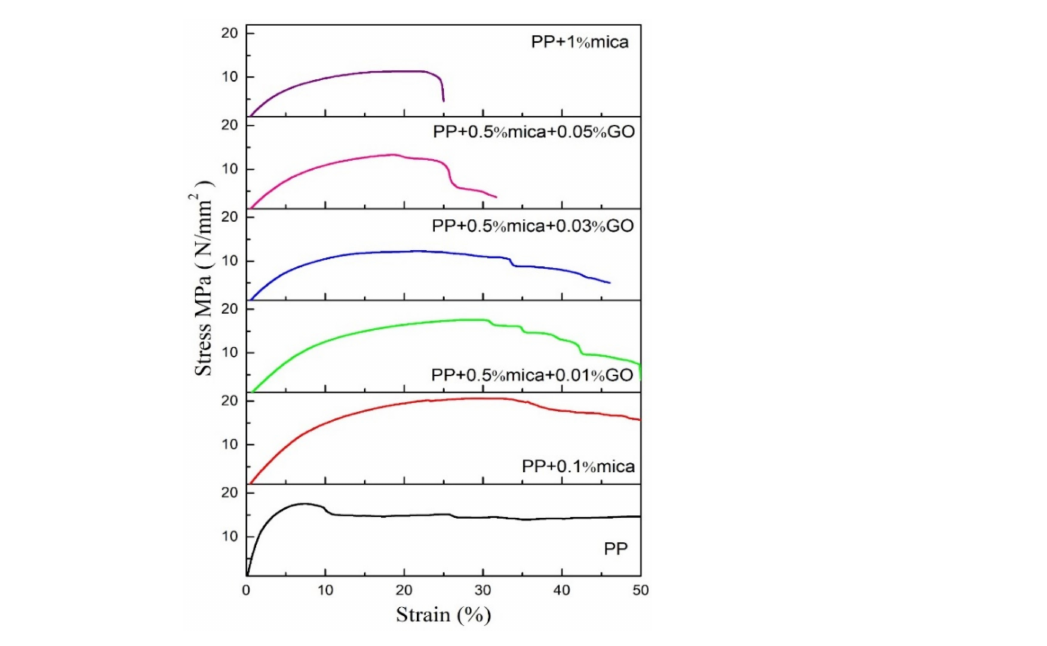
Figure 10. Tensile stress-strain curves of polypropylene, mica/polypropylene and graphene ox- ide/mica/polypropylene